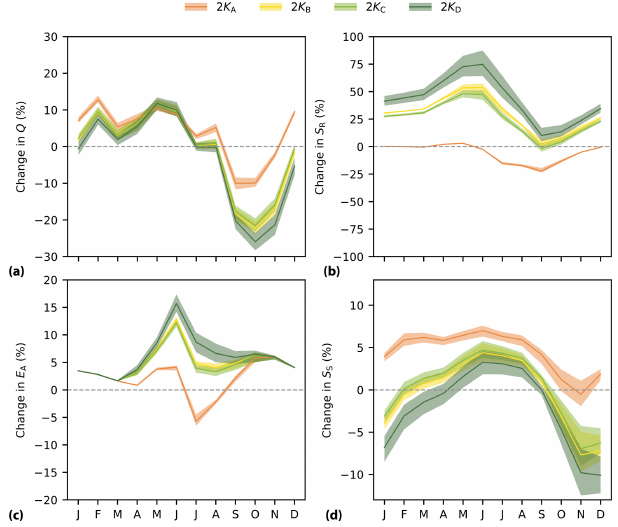
Figure 8. Percentage change in the mean monthly hydrological re- sponse of several flux and state variables between 2K and historical model runs for the four scenarios, each based on different assump- tions for the root zone storage capacity parameter S R , max . The per- centage change in mean monthly (a) streamflow Q , (b) root zone storage S R , (c) actual evaporation E A and (d) groundwater storage S S is shown. The lines and shaded areas show the median and 5th– 95th percentiles from the ensemble of parameter sets retained as